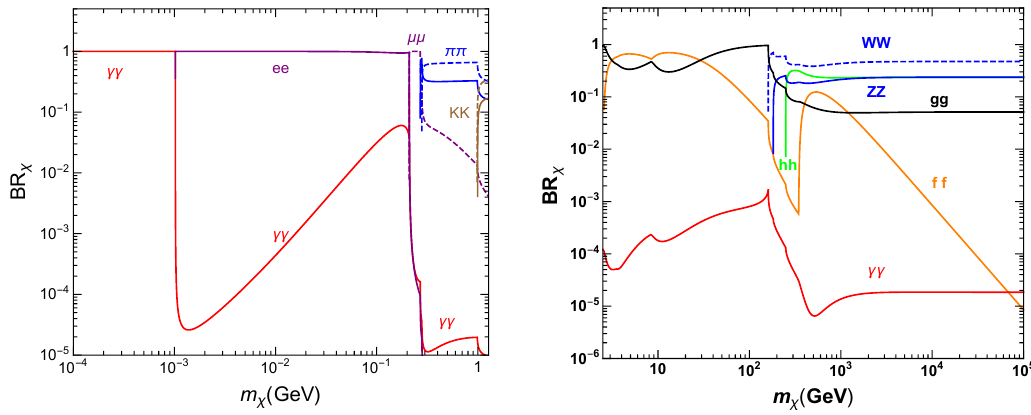
Figure 5 . Decay branching ratios of the in(cid:13)aton as a function of m (cid:31) . In(cid:13)aton masses are taken to 10 (cid:0) 4 GeV < m (cid:31) < m c on left and 2 : 5 GeV < m (cid:31) < 10 5 GeV on right. On left, dashed and solid lines in blue or brown are for charged and neutral mesons, respectively. Branching ratios are independent of (cid:24) 1